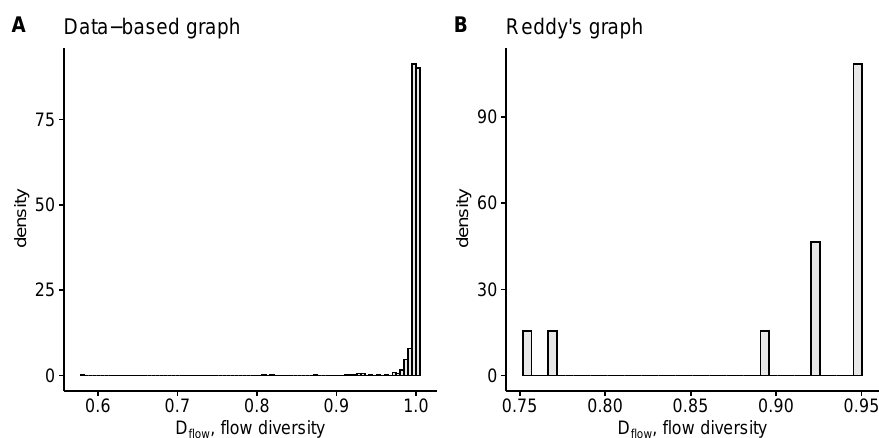
Figure 12. Histograms of the flow diversity of the inner vertices of anatomy-based graphs: ( A ) for data-based graph, ( B ) for Reddy’s